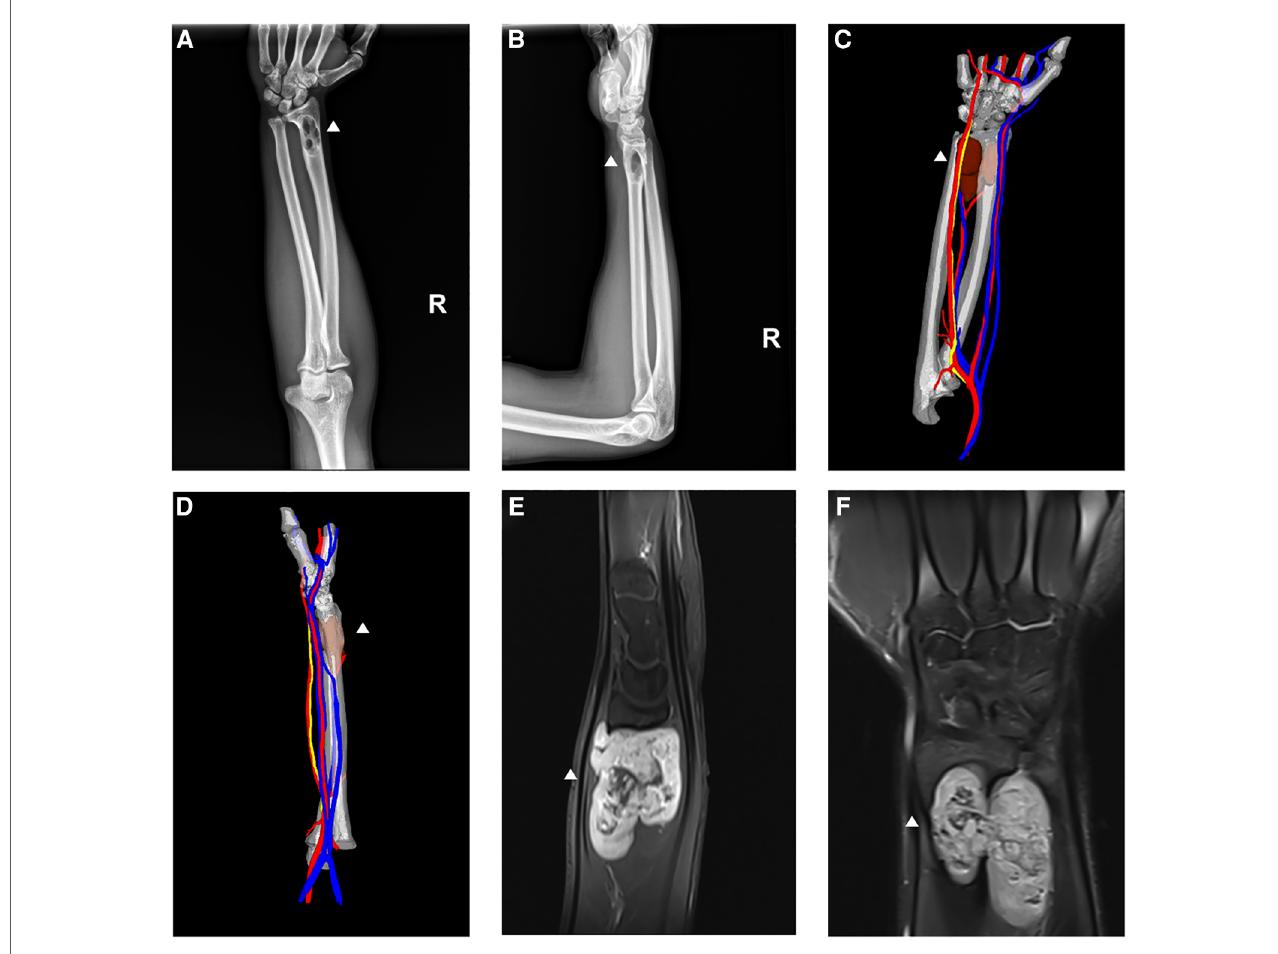
FIGURE 1 Preoperative imaging evaluation of the right forearm (white triangle indicates the location of the lesion). ( A,B ) Preoperative anteroposterior and lateral radiographs revealing the lesion in the right radius. ( C,D ) Three-dimensional computed tomography reconstruction demonstrating the positional relationship between the tumor and the bone in the anteroposterior and lateral views. ( E,F ) Lateral and anteroposterior magnetic resonance imaging indicating the invasion. The lesion measured approximately 4.8 cm×3.7 cm×3.6 cm, inclusive of the occupied